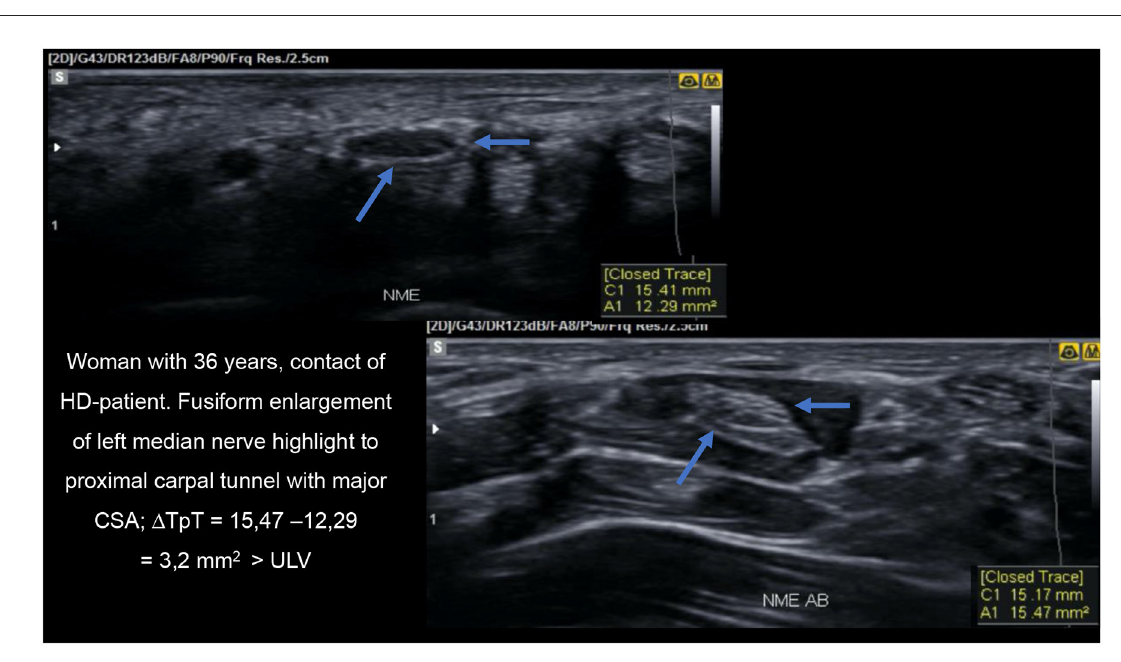
no longer revealed differences in asymmetry and focality between HHC and patients with HD, with the two groups being